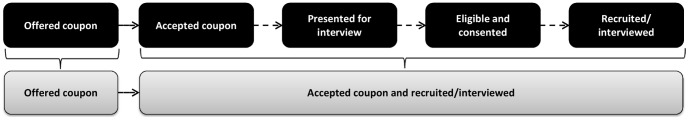
Diagram of the RDS recruitment process.